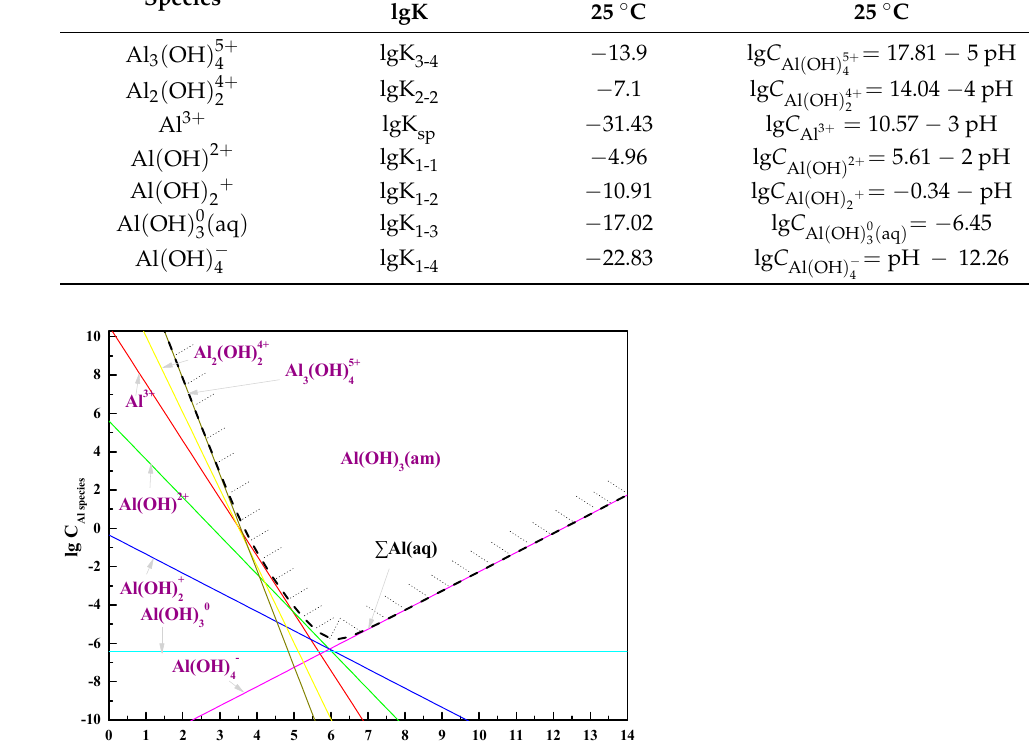
Table 2. The parameters and equations of the stepwise hydrolysis of Al 3+ . Equilibrium Constants Equations Species